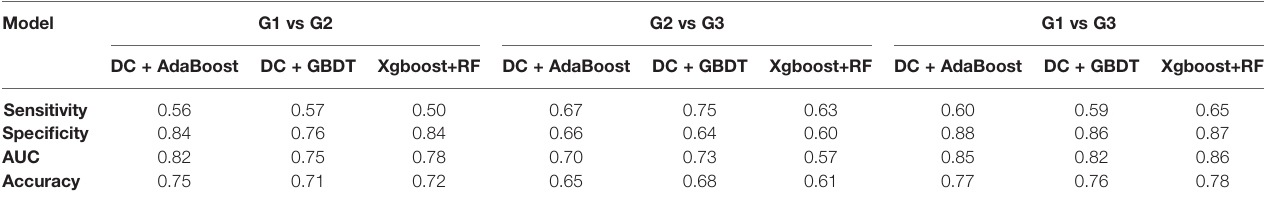
TABLE 3 | Diagnostic performance of the optimal discriminative model in validation set.